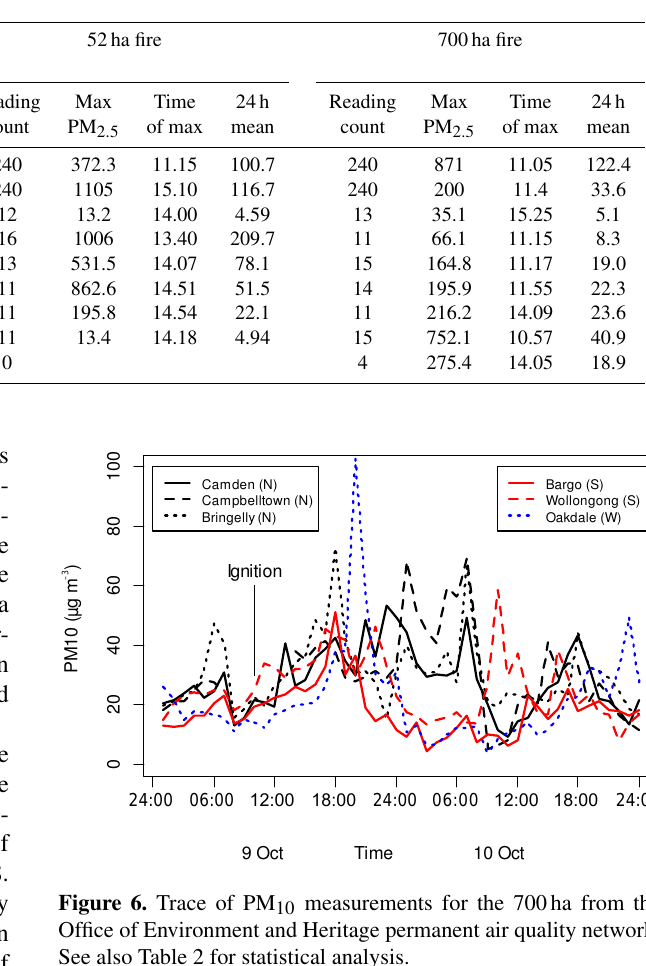
Table 1. Locations for particulate monitor readings, along with the maximum PM 2 . 5 reading, time of that reading and 24h average value. Locations other than the reference monitors were estimated assuming value of 4µgm − 3 for non-observed periods.